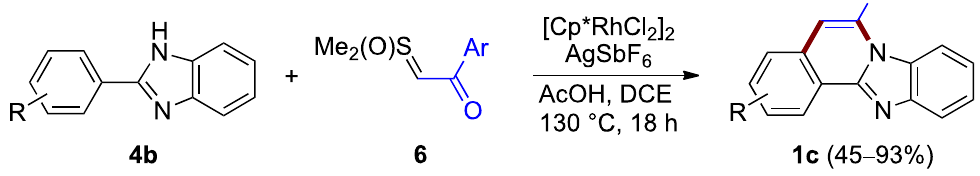
Figure 5. Annulation of benzimidazole 4b with sulfoxonium ylides 6 .